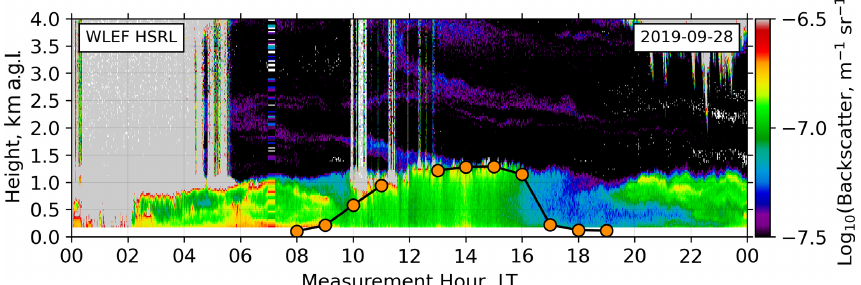
Figure 8. Time–height cross section of the HSRL aerosol backscatter measurements at the WLEF site that were used to subjectively determine the PBLH estimates for 28 September 2019. Overlaid are the subjectively determined hourly mean PBLH estimates (orange dots) during the daytime.